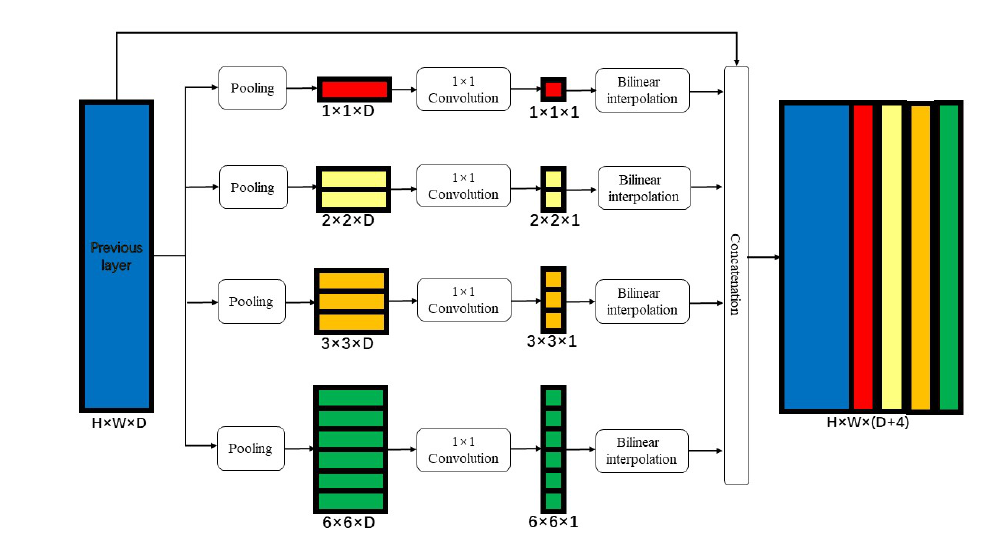
Figure 1. Structure of pyramid pooling